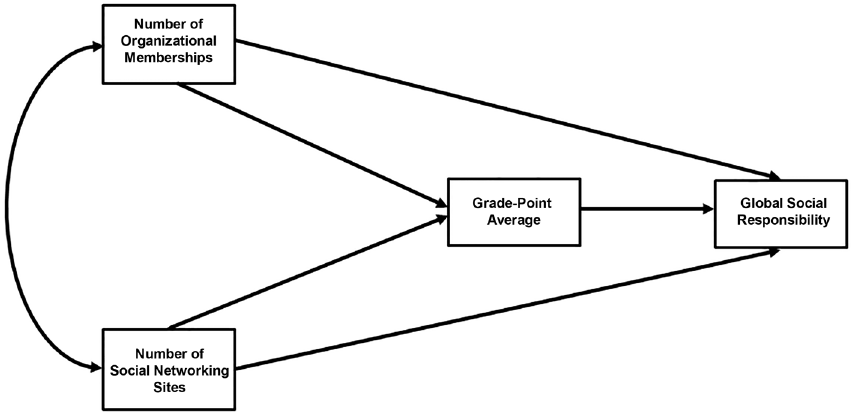
Figure 1. Structural path